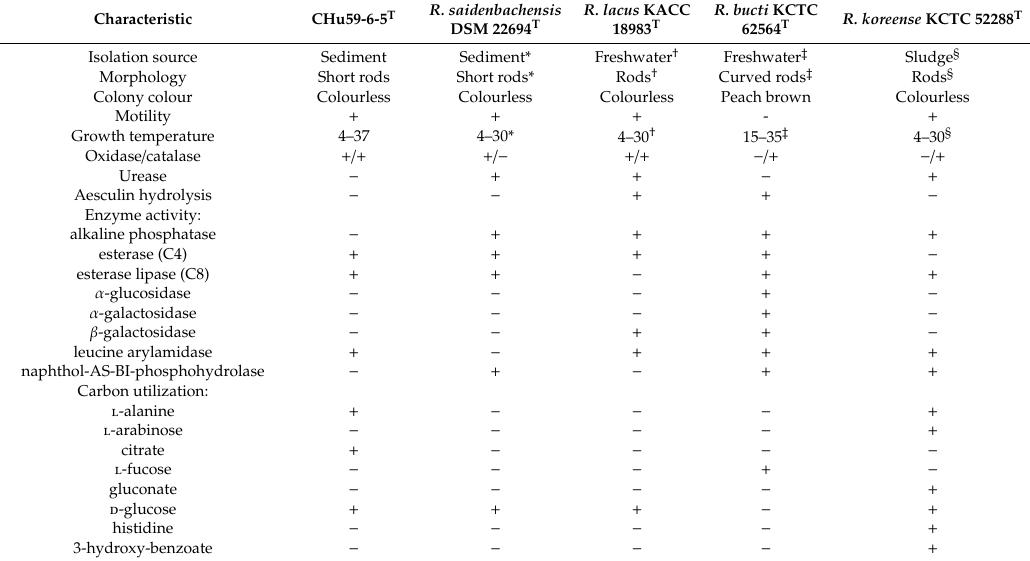
Table 1. Features that di ff erentiate strain CHu59-6-5 T from the most closely related species in the genus Rhodoferax